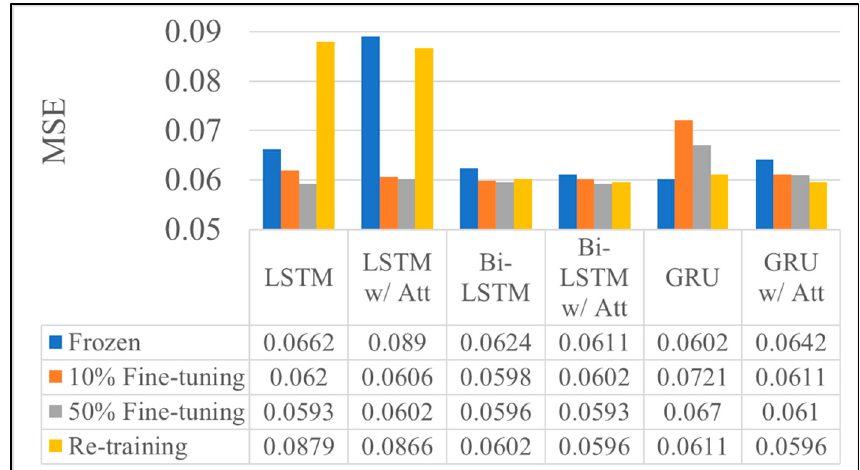
Figure 9. MSE of the source disease course prediction of TL-CDC under k = 2.